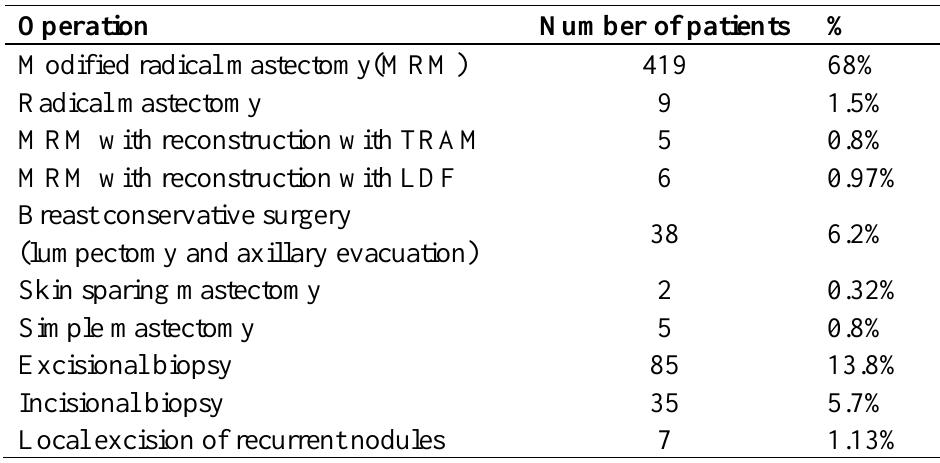
Table 1. Frequency and type of surgical